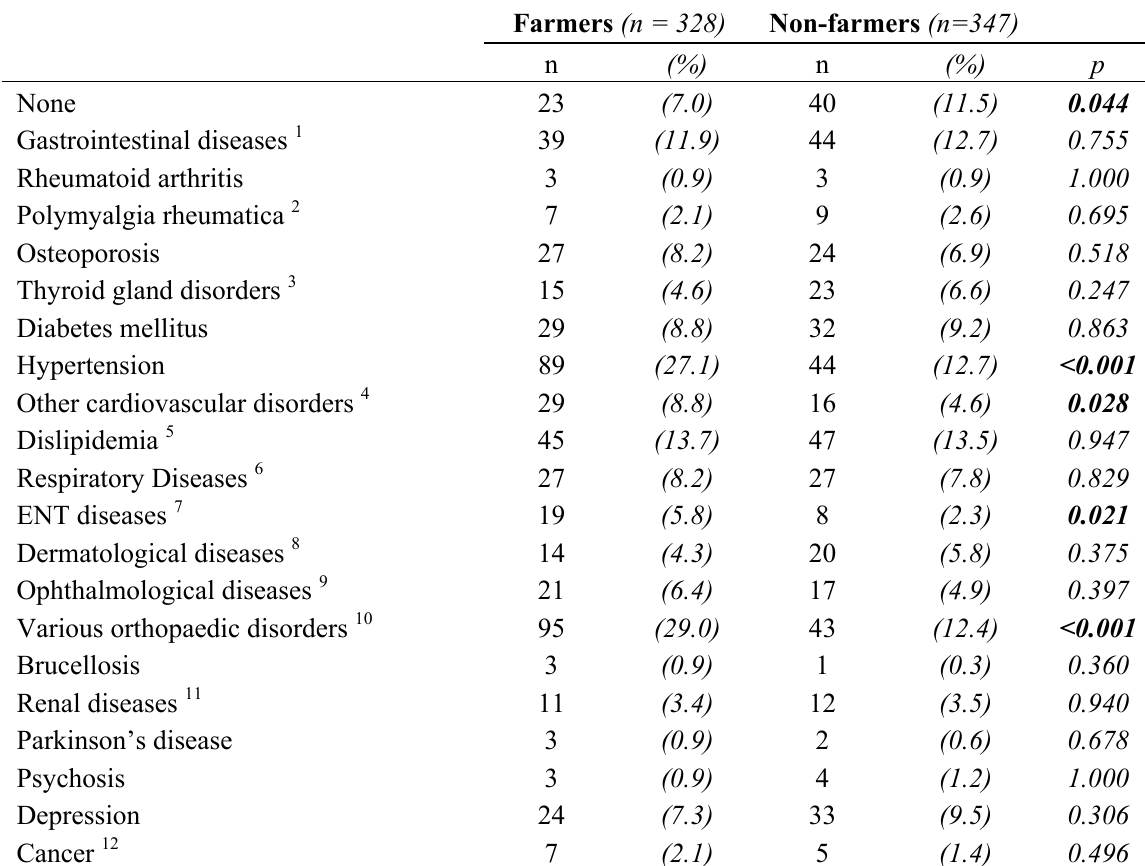
Table 2. Morbidities according to subjects’